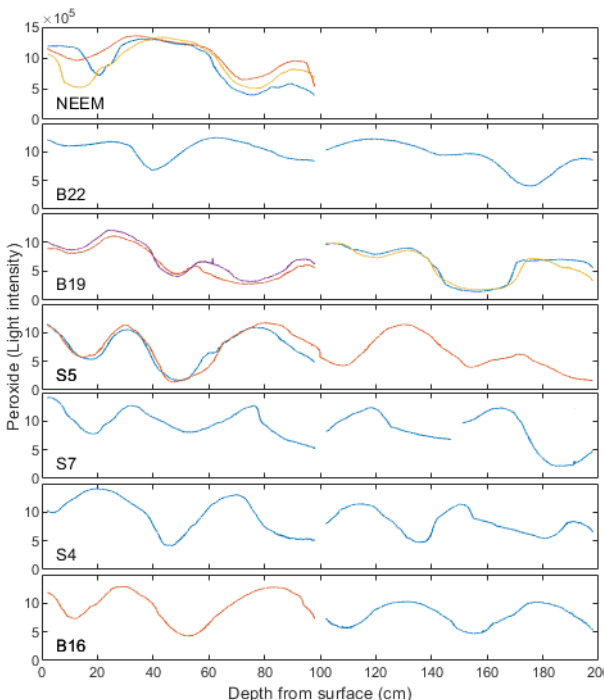
Figure 5. Hydrogen peroxide with depth for seven sites in northern Greenland (clockwise from north-west). For the NEEM, B19 and S5 sites, several cores were retrieved. Colours indicate when multiple snow cores were collected or when the top and bottom of a pit were not measured in one run. The data are not calibrated, and the y axis is raw light intensities; thus, while the level reflects the hydrogen peroxide concentration, absolute values are not to be